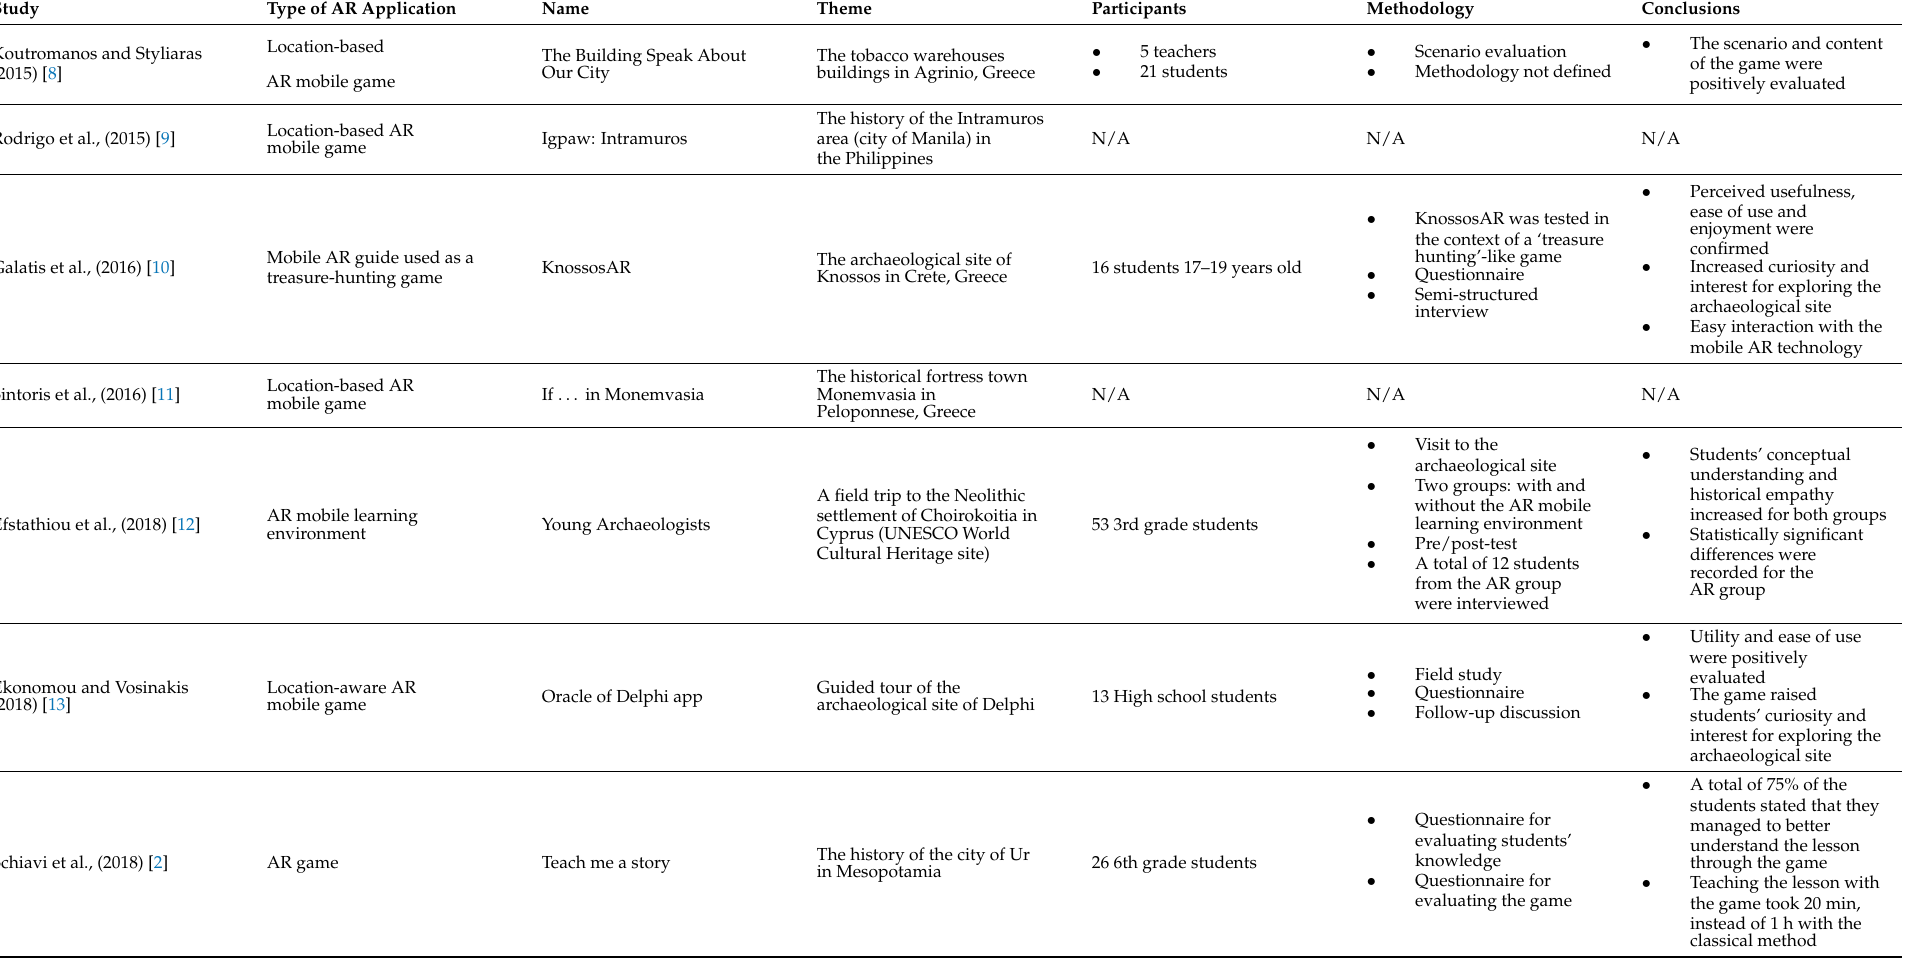
Table 1. Review of studies on AR applications for